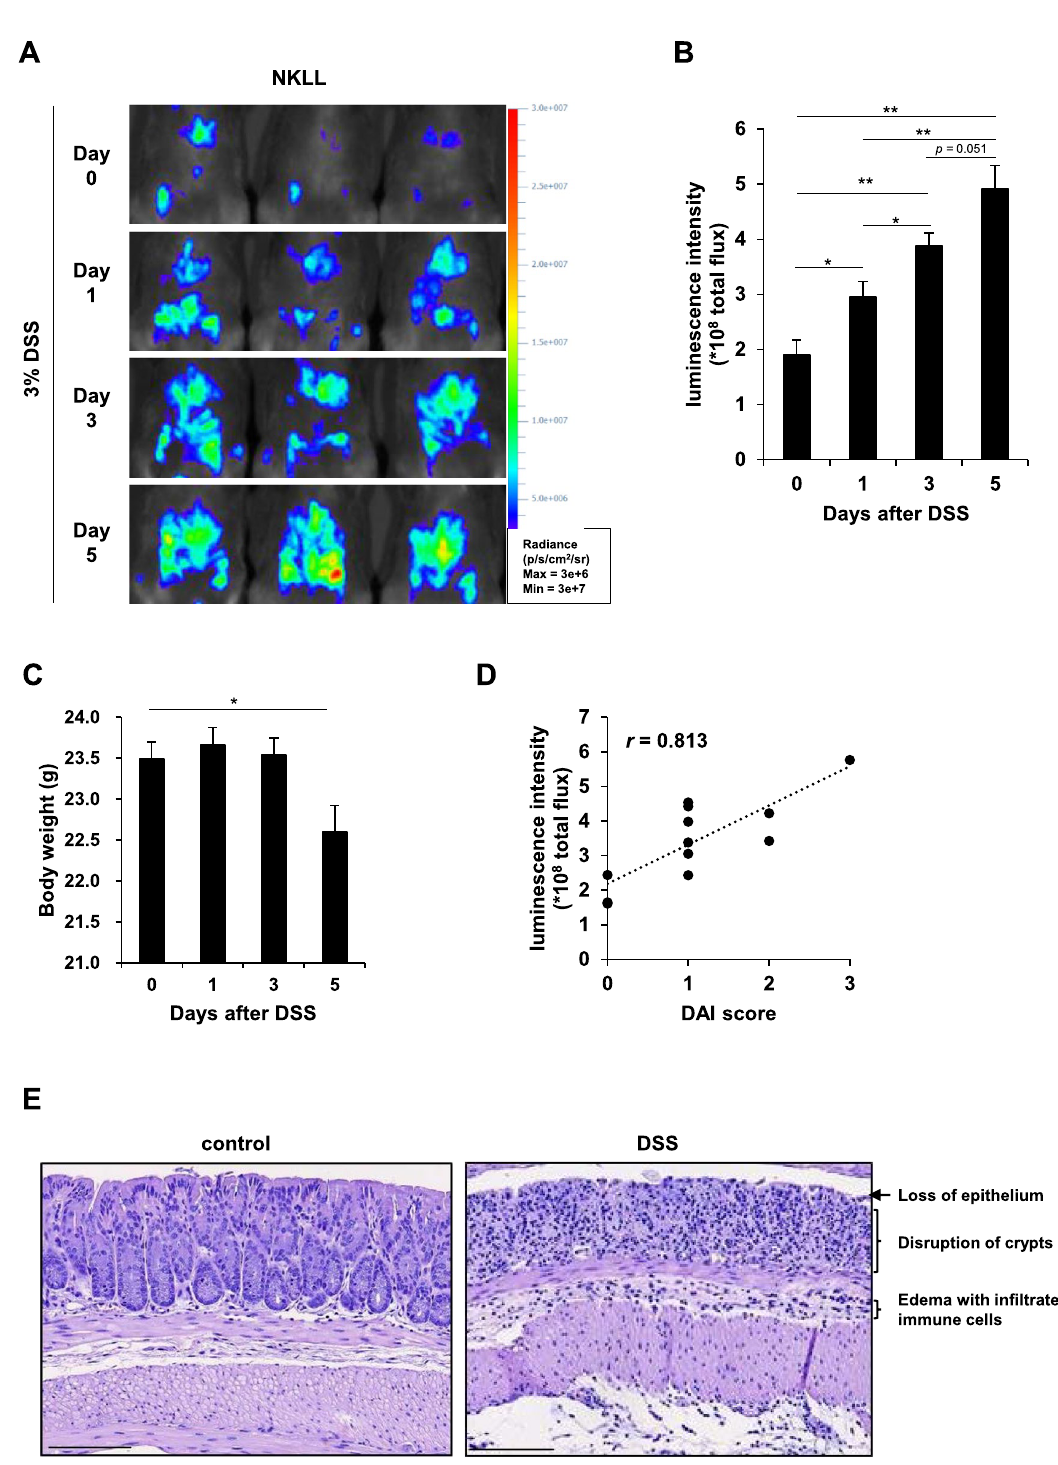
Figure 4. Non-invasive monitoring of inflammatory signals in the IBD model. NF-κB-Luc:Lyz2 (NKLL) mice were treated with 3% (w/v) dextran sodium sulfate (DSS) in drinking water for 5 days (n = 3) ( A ) Abdominal bioluminescence images and ( B ) luminescence intensities. Radiance ranges are provided in the figure. Luminescence intensity increased time-dependently after DSS treatment. ( C ) Body weight change during DSS treatment. ( D ) Correlation between DAI scores and luminescence intensities. The correlation coefficient ( r ) is shown in the figure. ( E ) Representative images of HE staining of colon tissues from mice before (control) and after 5 days of DSS treatment (DSS) (Scale bar = 100 μm). Histopathological features are indicated in the figure. * p < 0.05, ** p <